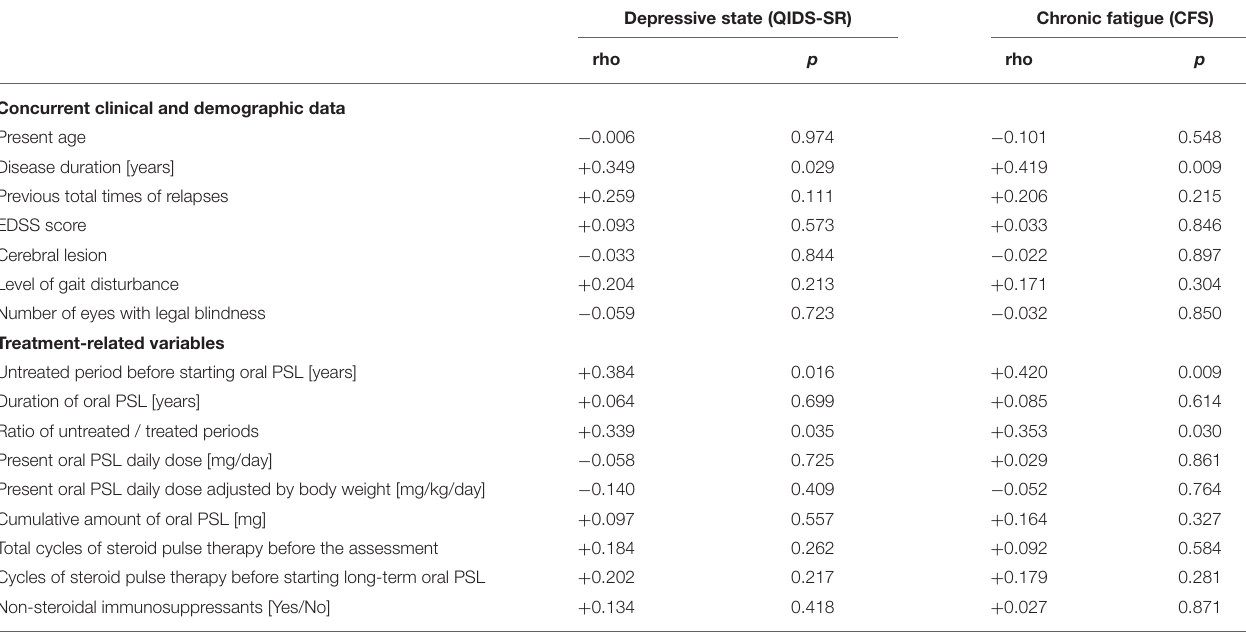
TABLE 2 | Correlation matrix between the studied symptoms and concurrent other variables in total cohort ( n = 39).